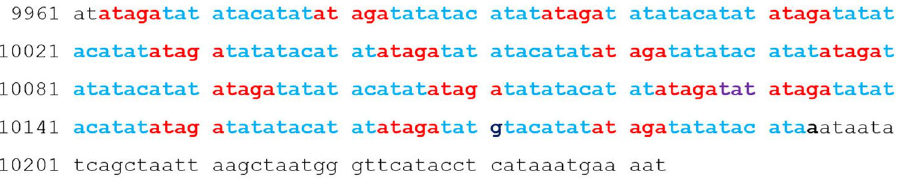
Figure 5. Fifteen tandem repeats of ATAGA motif with TAT ATA CATAT stretch (except one each with TAT, TAT GTA CATAT, and TAT ATA CATAA) in the control region of Trichonephila clavata checked using Tandem Repeats Finder (http:// tandem. bu. edu/ trf/ trf.